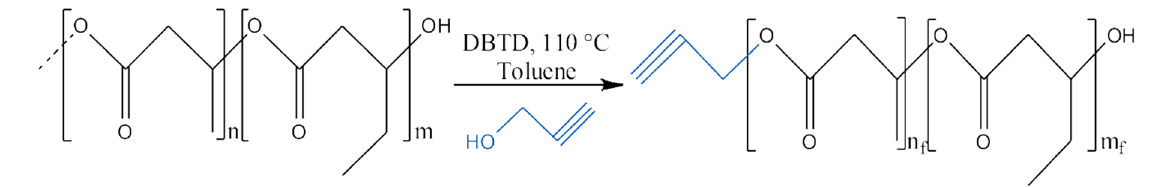
3 used in this work. Figure 1. Chemical structure of PullN